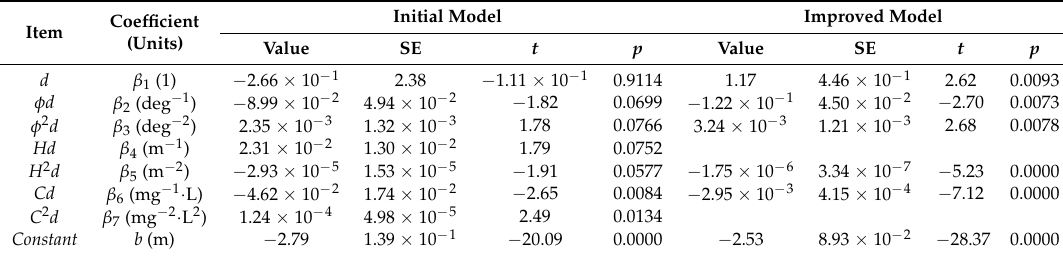
Table 4. Coefficients and t -test results of the initial and improved depth bias models. SE: standard error; t : t